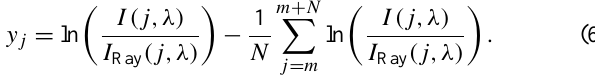
Fig. 4. Modelled sensitivity of the aerosol measurement vectors from scan 6432001 as a function of wave- length for three particle size distributions at 22.5km. Panel (A) shows the size distributions at 22.5km, with parameters listed in Table 1. Panel (B) shows the measurement vectors as a function of wavelength for the three distributions. Panel (C) shows the relative difference between the measurement vectors compared to the bimodal state. The shaded area shows error in the bimodal measurement vector due to 1% error in the measured radiance.